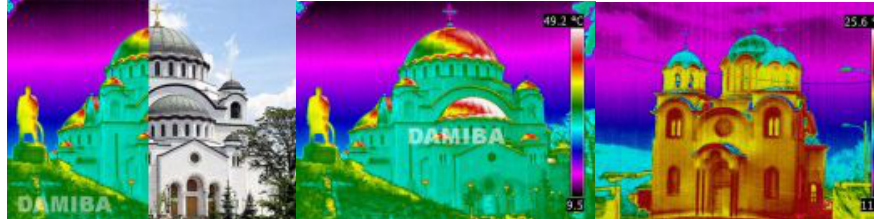
Figure 2 – Thermal images of the Saint Sava’s Temple in Belgrade and a Bole č Church (suburb of Belgrade) (http://www.termografija.rs, 2015) Рис . 2 – Тепловое изображение Храма Святого Саввы и церкви в п . Болеч (http://www.termografija.rs, 2015) Слика 2 – Термовизијска слика Храма Светог Саве и цркве у Болечу (http://www.termografija.rs, 2015)